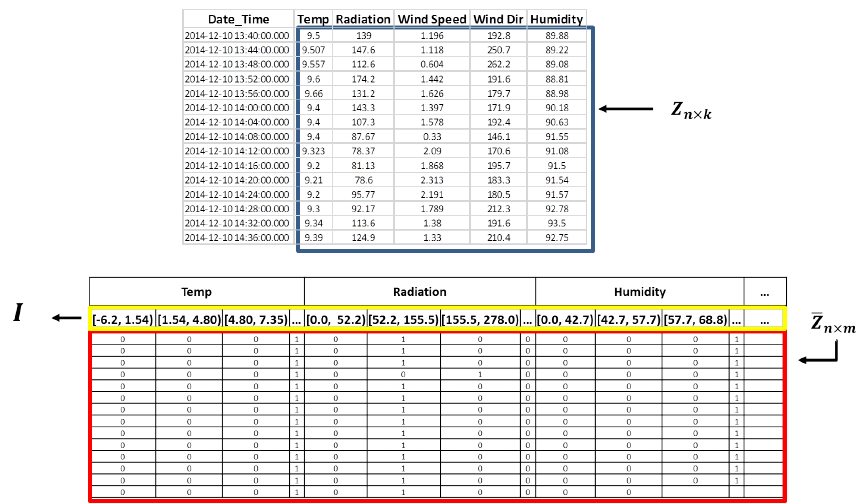
Figure 6. Part of the data set before ( Z ) and after discretization (¯ Z